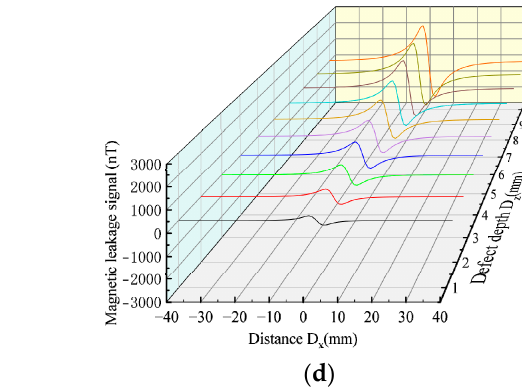
Figure 14. Comparative analysis of MFL signals between the improved magnetic charge model and the classical magnetic charge model under different defect depth. ( a ) MFL of the axial component of the improved magnetic charge model with different defect depth. ( b ) MFL of the radial component of the improved magnetic charge model with different defect depth. ( c ) MFL of axial components of classical magnetic charge model with different defect depth. ( d ) MFL of radial components of classical magnetic charge model with different defect depth.